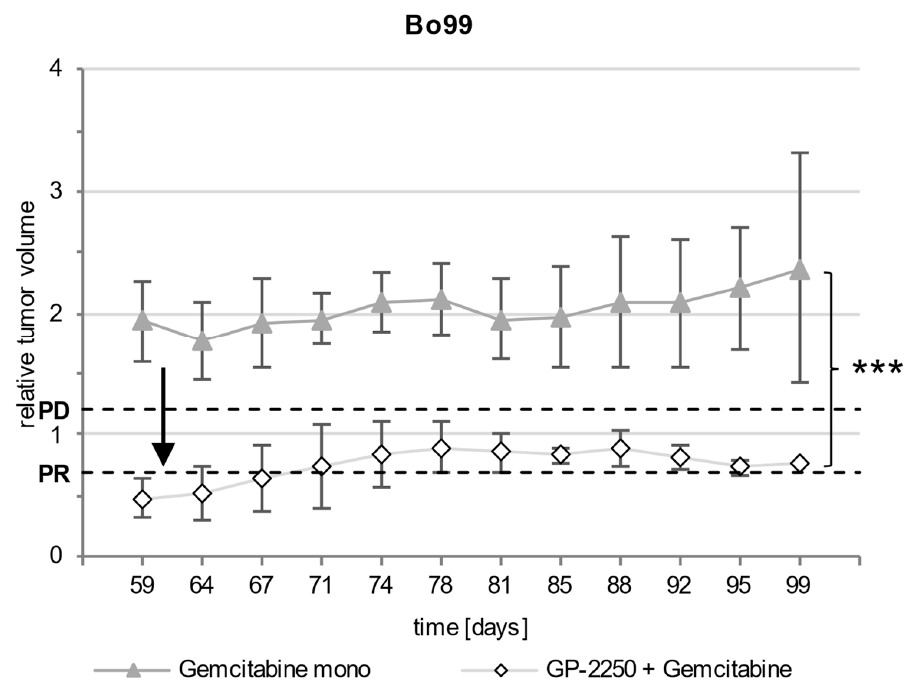
Figure 5. Development of the relative tumor volume during the follow-up period. Figure 5 shows the development of the relative tumor volume during the follow-up period of Bo99 tumors treated with Gemcitabine mono and a combination of Gemcitabine and GP-2250. The arrow indicates the start of the therapeutic break of the combination cohort. PD, progressive disease; PR, partial response. Error bars show the standard deviation. p -values are indicated as follows: *** p ≤ 0.001.